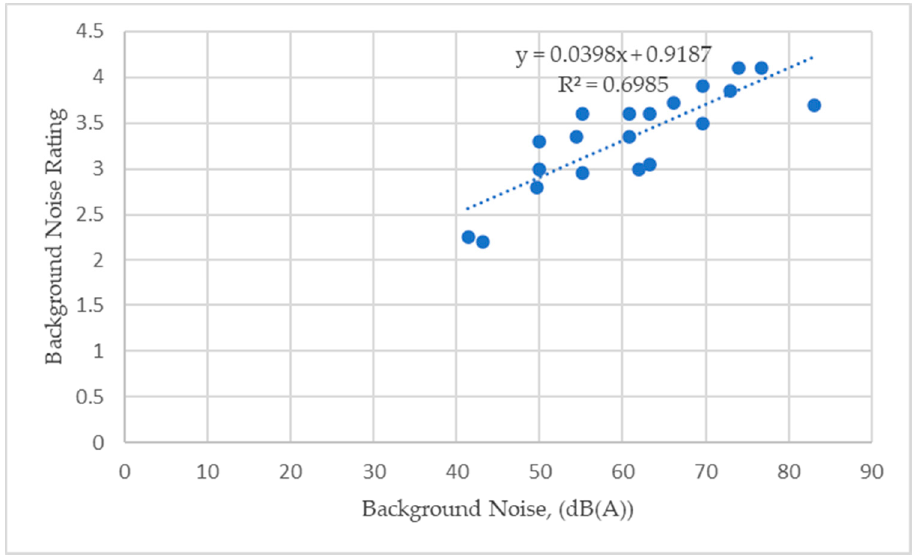
Figure 14. Subjective rating of background noise and ambient noise level measurements.